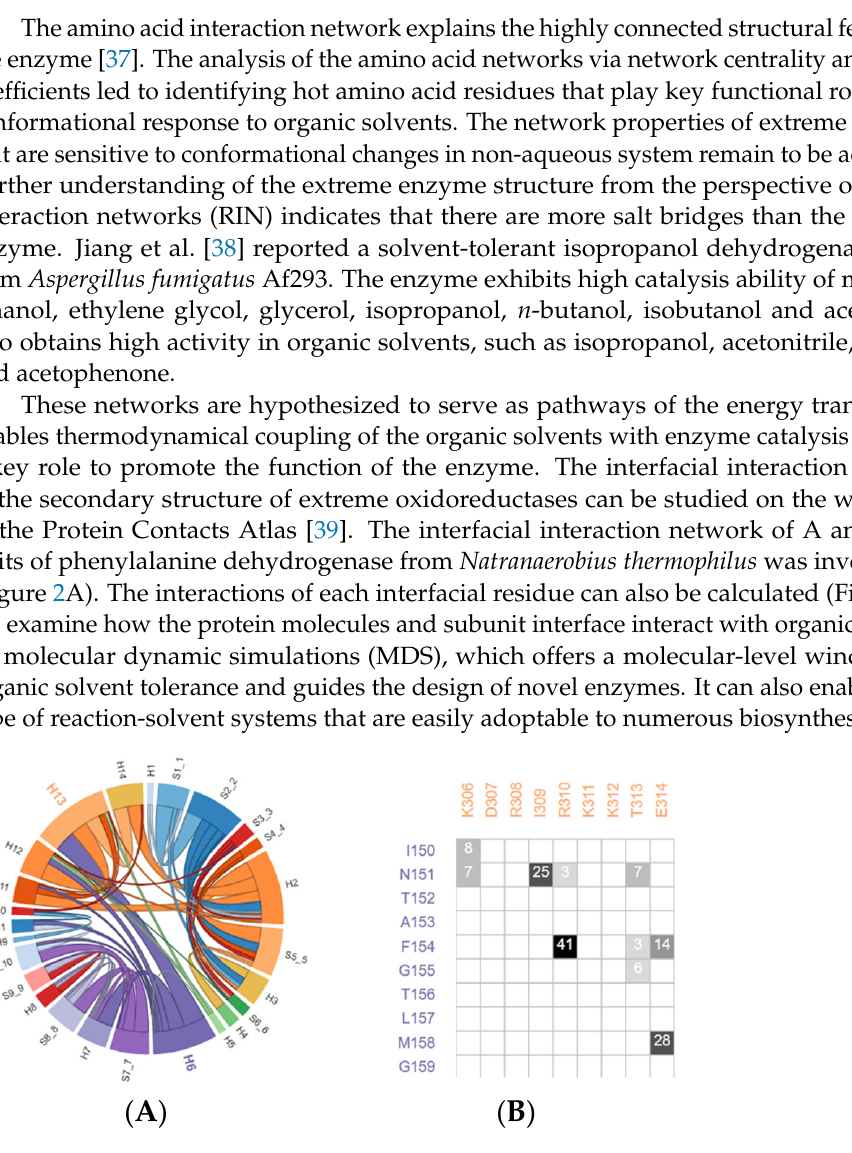
Figure 2. ( A ) Interfacial interactions of the secondary structure of phenylalanine dehydrogenase from Natranaerobius thermophilus by Protein Contacts Atlas; ( B ) Interactions heatmap of HELIX6- HELIX13 interactions.